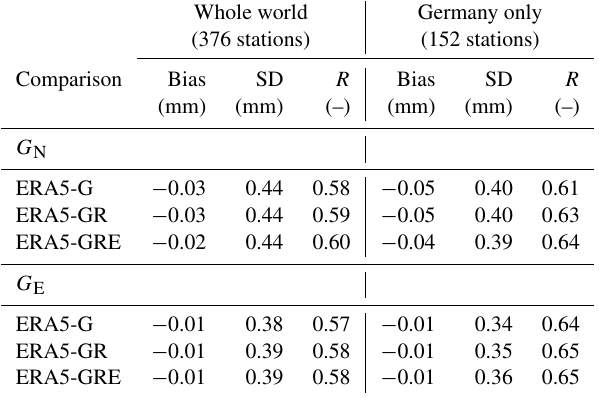
Table 6. Biases, SDs and Pearson’s correlations between the ERA5 and GNSS solutions for tropospheric gradients averaged from the year